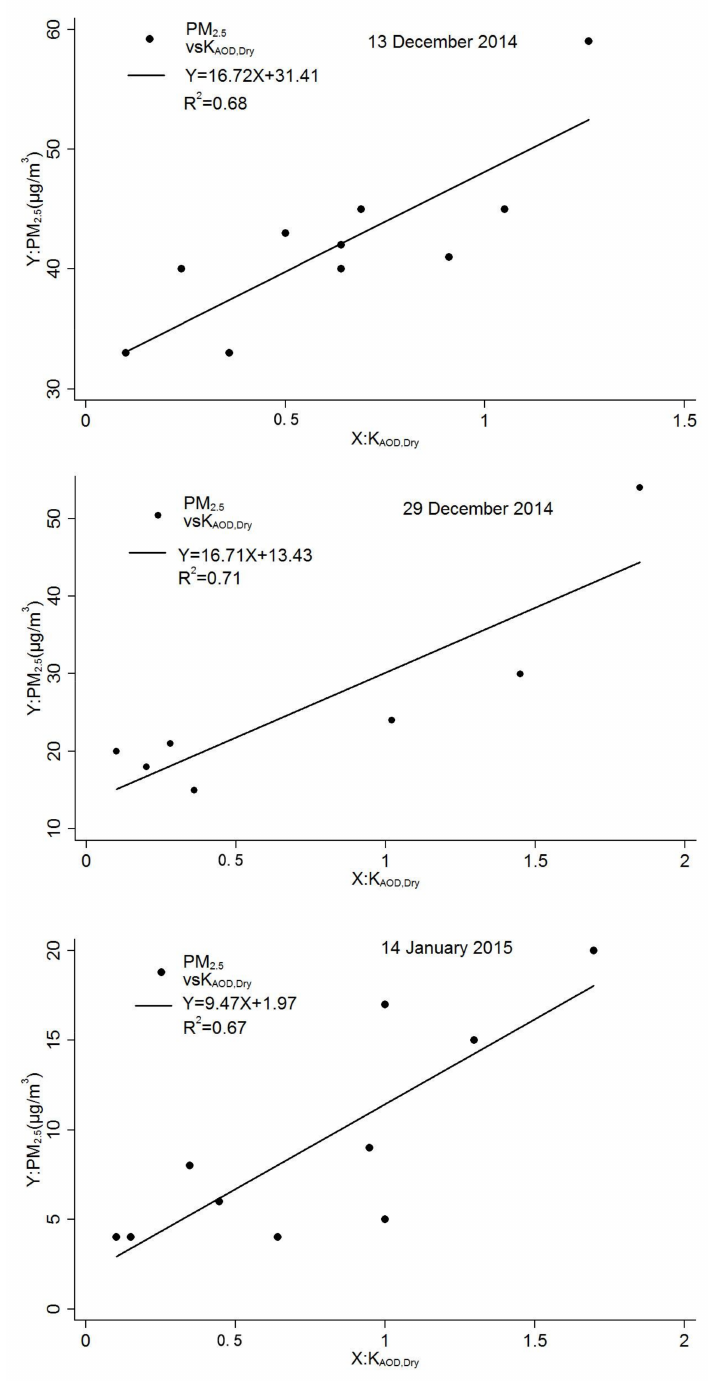
Figure 1. Correlation between k AOD , Dry and PM 2.5 concentrations on 13 December 2014, 29 December 2014, and 14 January 2015 (both acquired from Environmental Protection of Jinjiang k AOD , Dry represents the aerosol extinction coefficient in dry